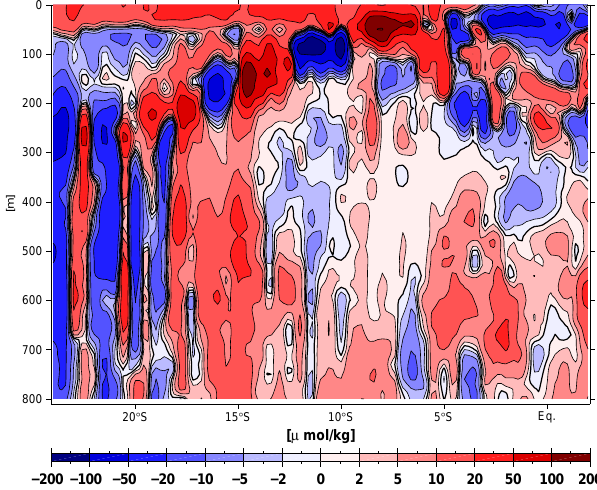
Figure 11. Oxygen differences along the section at about 86 ◦ W between November 2012 and March